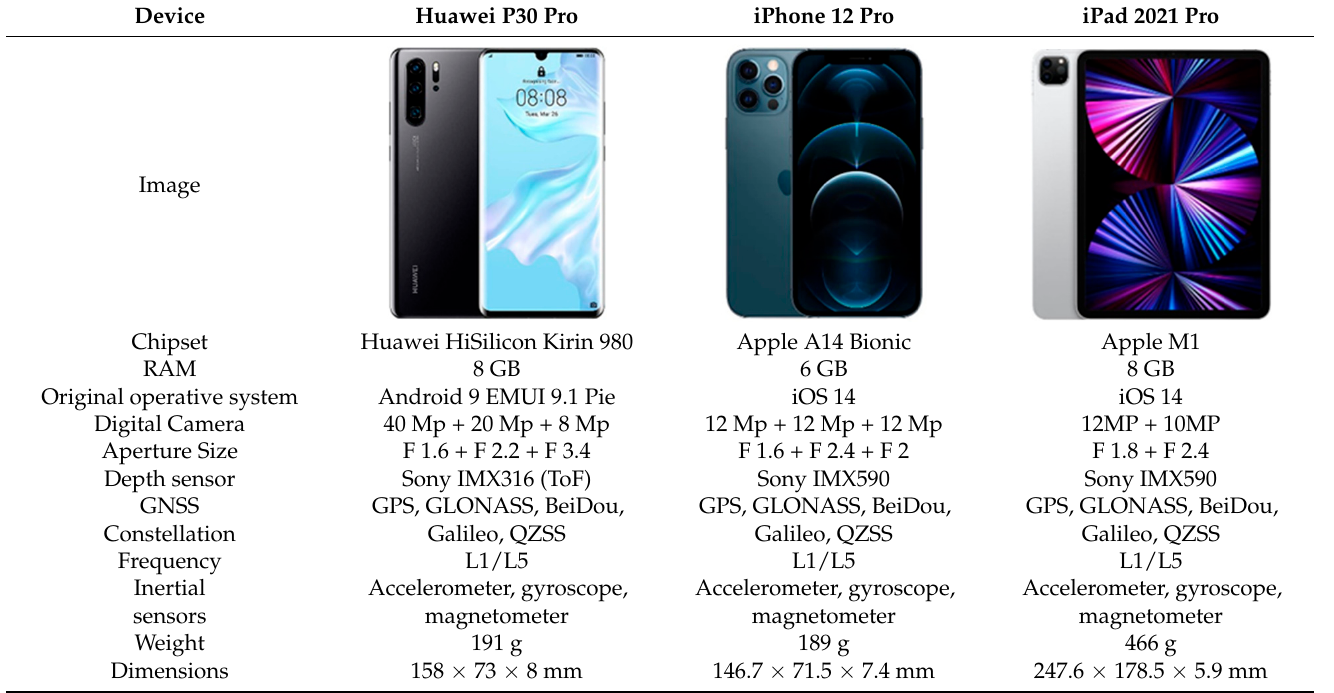
Table 1. Main technical features of the 3 mobile devices used in the experimentation.